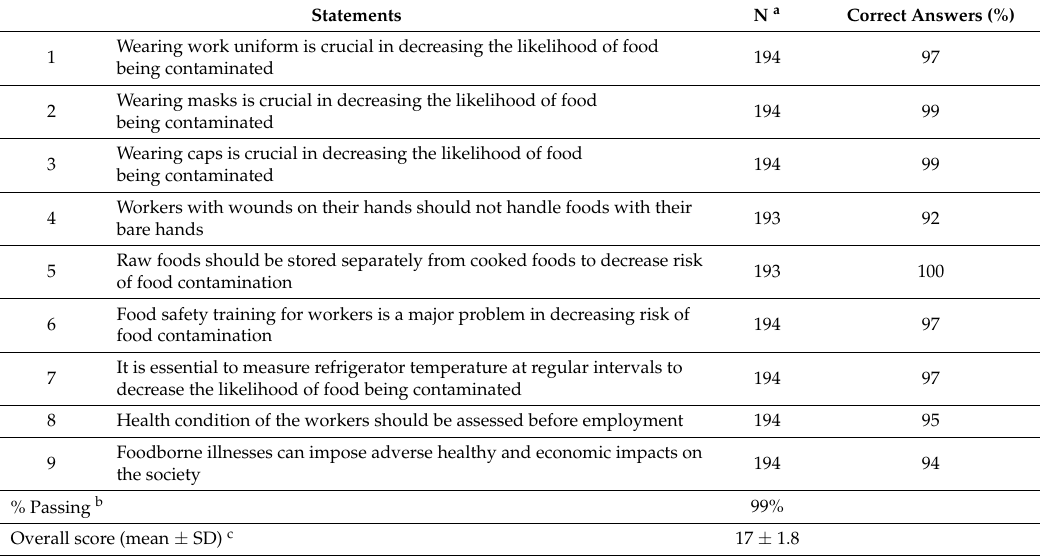
Table 3. Food safety related attitudes among dairy plant workers.